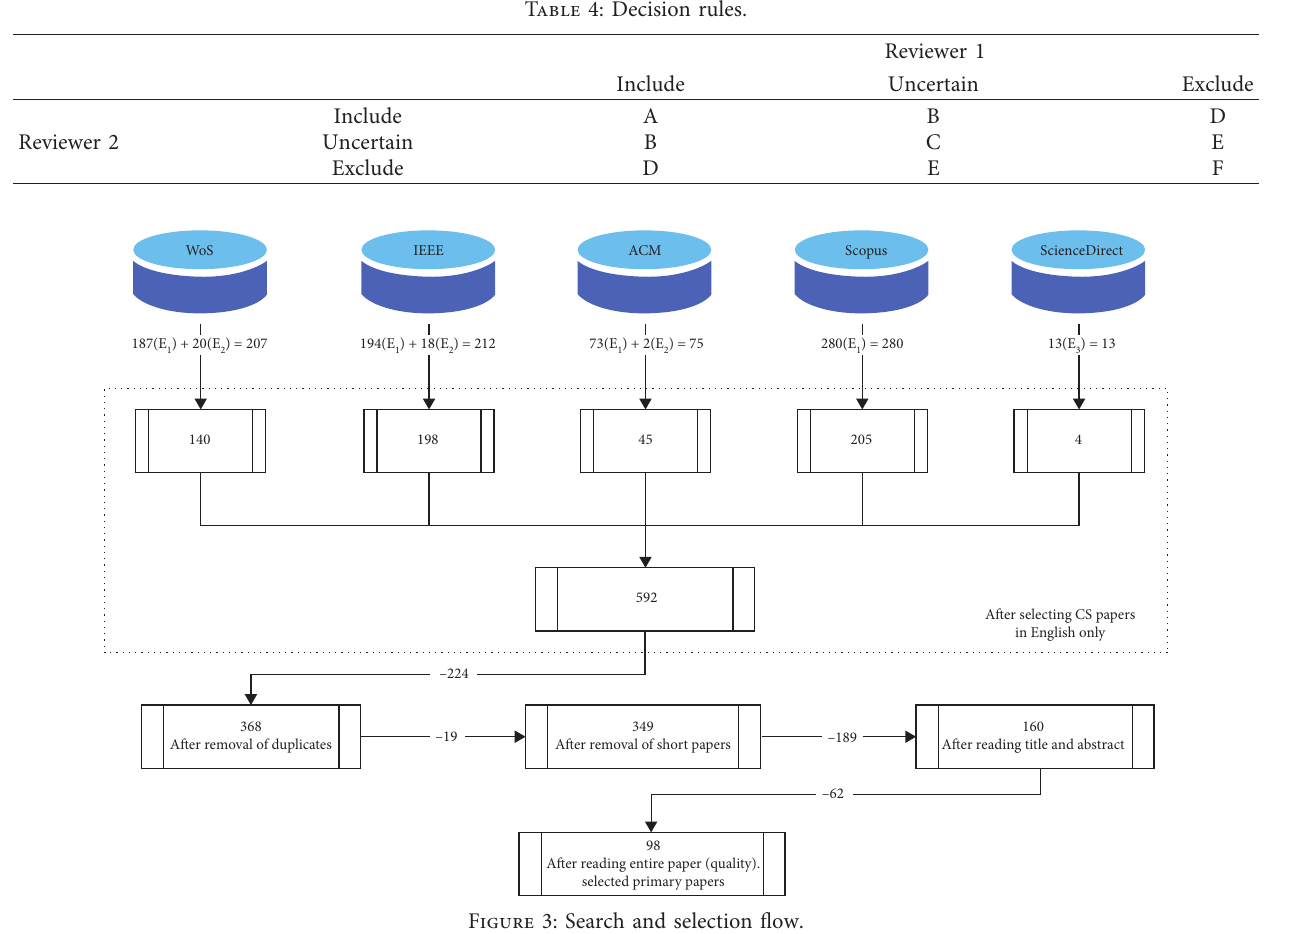
Table 4: Decision rules.